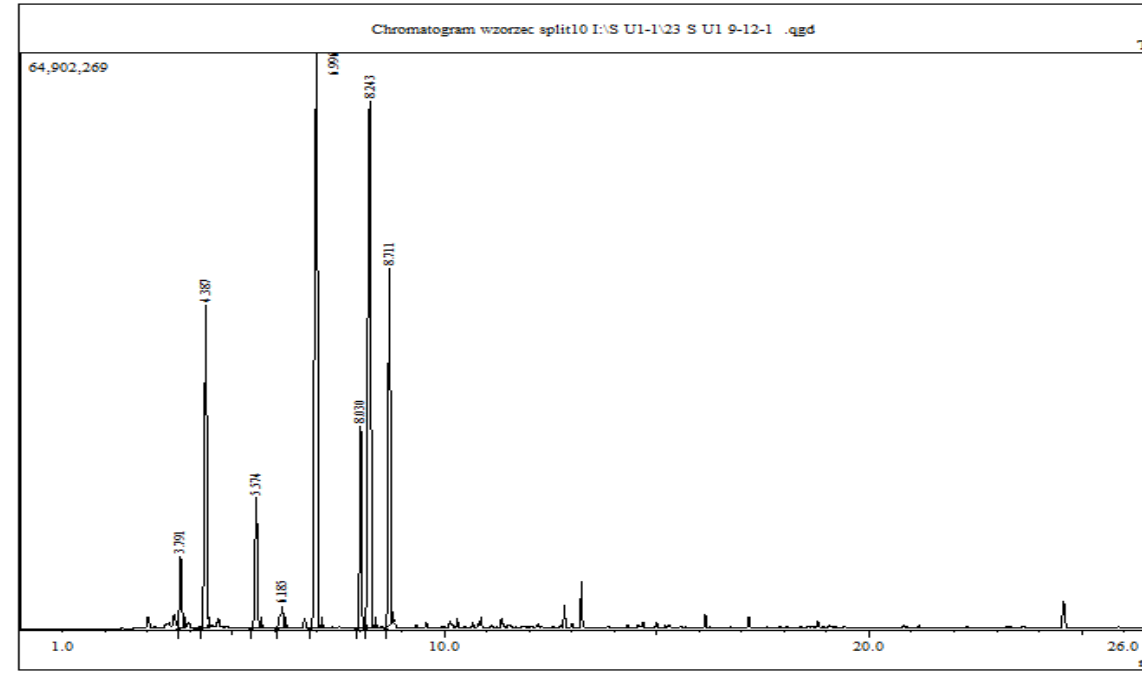
Figure A2. Chromatogram of polyurethane–epoxy adhesive—example.